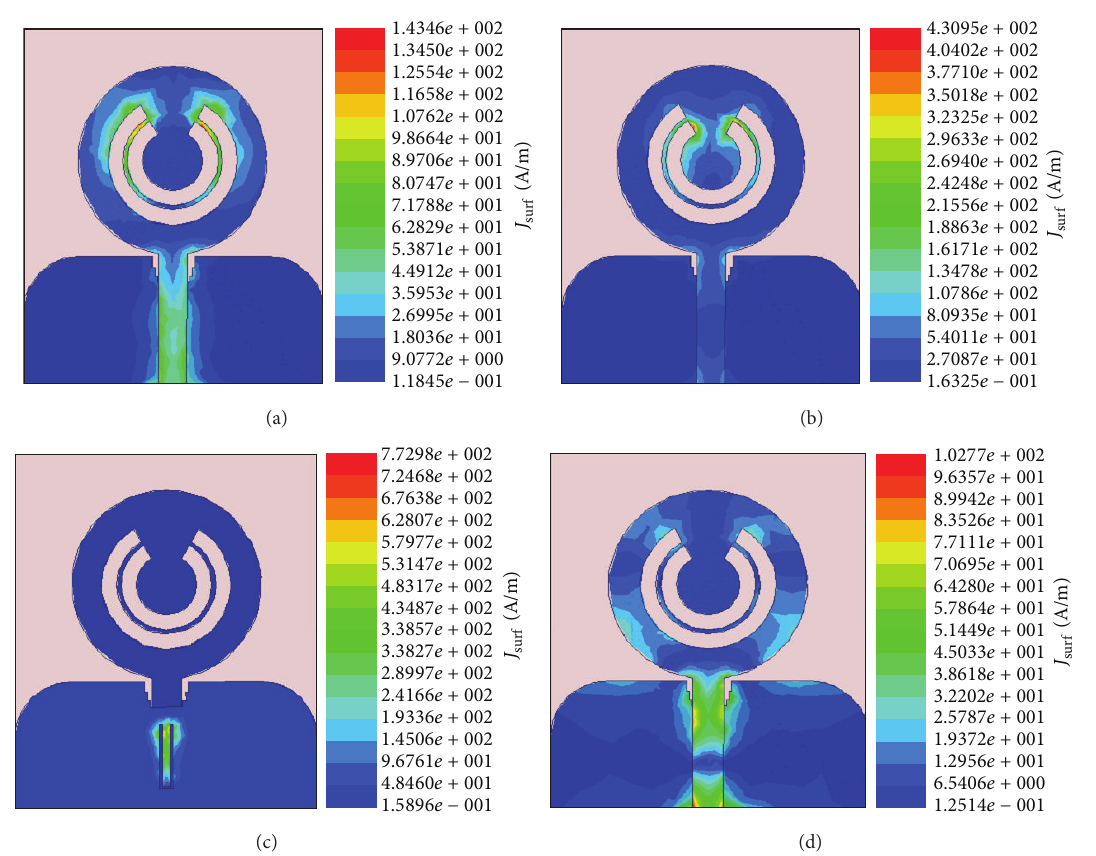
Figure 8: Surface current distributions. (a) The first notched band at 3.6 GHz, (b) the second notched band at 5.2 GHz, (c) the third notched band at 7.3 GHz, and (d) a passband frequency of 8.9 GHz.